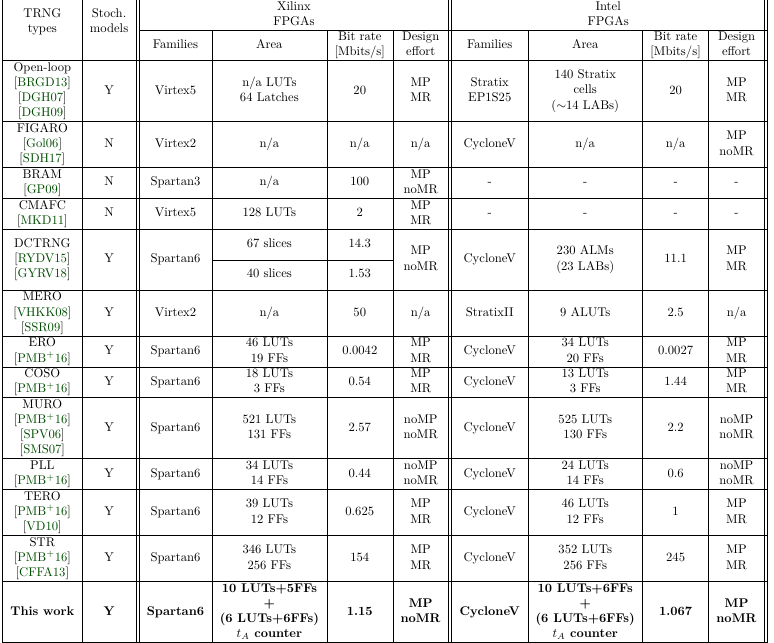
Table 3: The comparison with existing TRNG